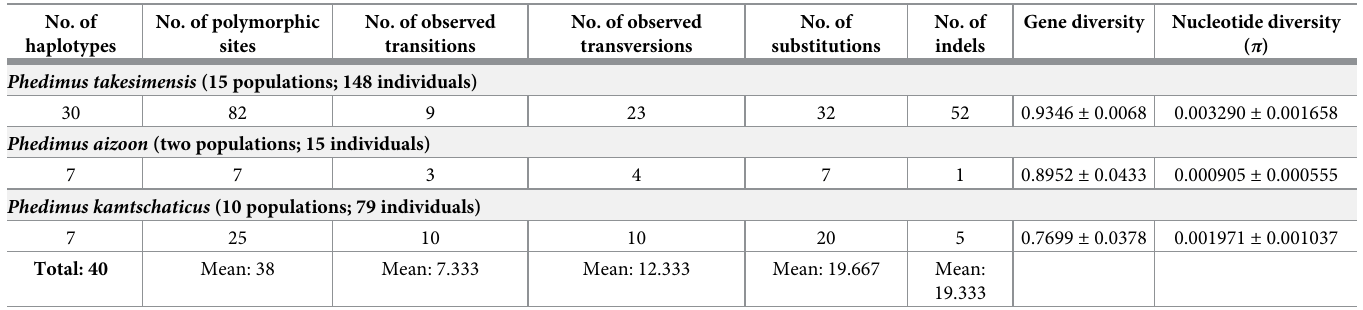
Table 3. Summary of chloroplast DNA variation for Phedimus takesimensis , P . aizoon , and P . kamtschaticus